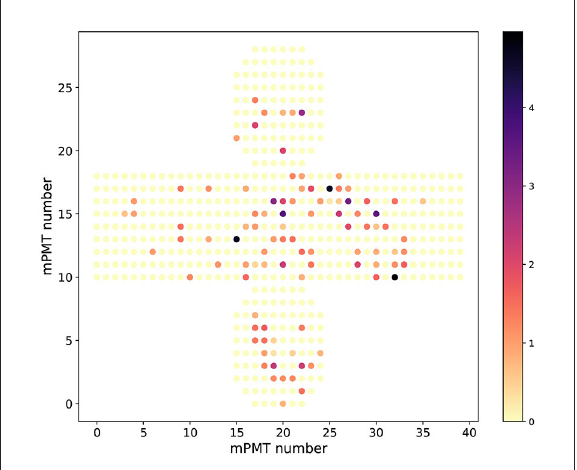
FIGURE1 Unrolled cylinder event displays showing the charged deposit in units of photoelectrons as the colored points for a sample electron background event. Multi PMT modules without any charge are shown in